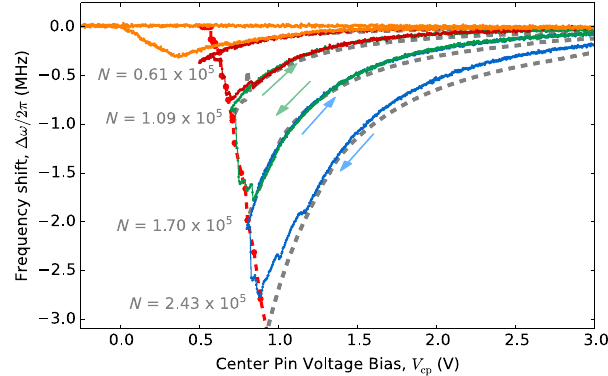
4. Measured cavity frequency shifts as a function of trap voltage bias V . Colors indicate consecutive cycles of the voltage cp sweep. In each cycle V is decreased (arrows) until electrons are cp irreversibly lost from the trap and then increased to the initial value of 3.0 V. Gray dashed lines in the background show frequency shifts predicted by molecular dynamics simulation. For each of the four isoelectron number curves the number of electrons in the simulation is depicted to the left. A red dotted line indicates modeled electron loss with respect to a leak voltage of (530) mV. The isoelectron number curves from the experiment terminate within a small neighborhood of this loss